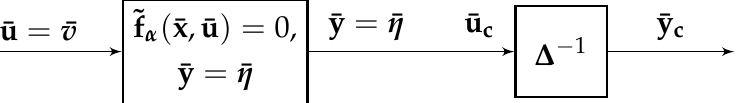
Figure 5. Open-loop interconnection (in the steady-state case) of the quadrotor rotational subsys- tem (33) and the SNI controller (35) (where ‘ c ’ refers to the